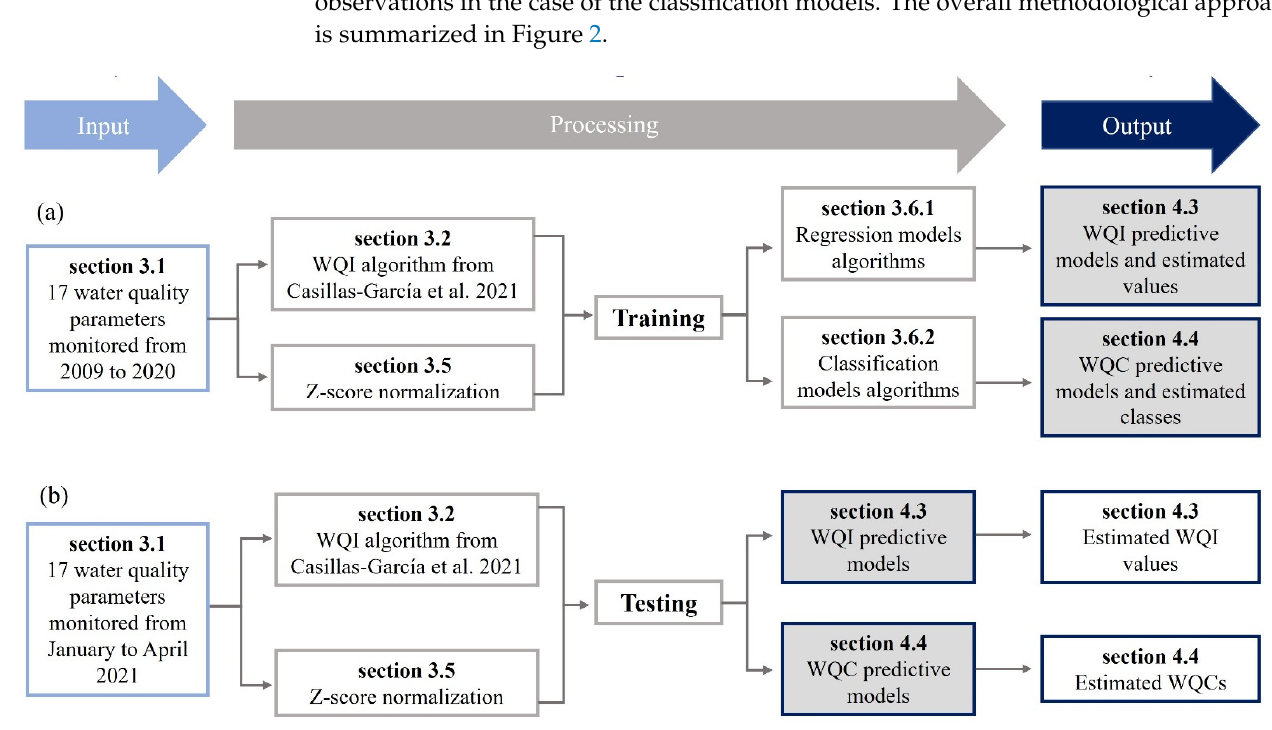
Figure 2. Overall methodological approach for training and testing the predictive models. ( a ) training approach and ( b ) testing approach.